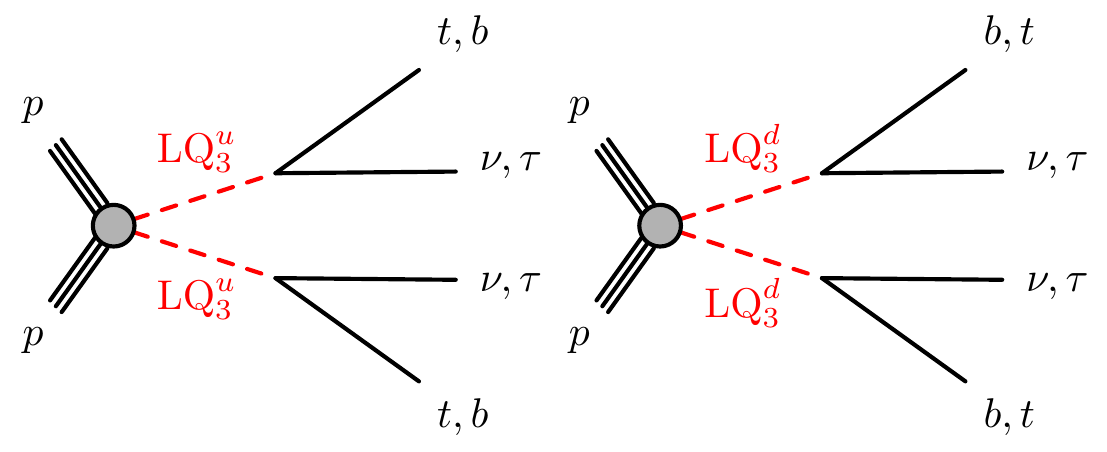
Figure 1 . Pair production and decay of LQ u